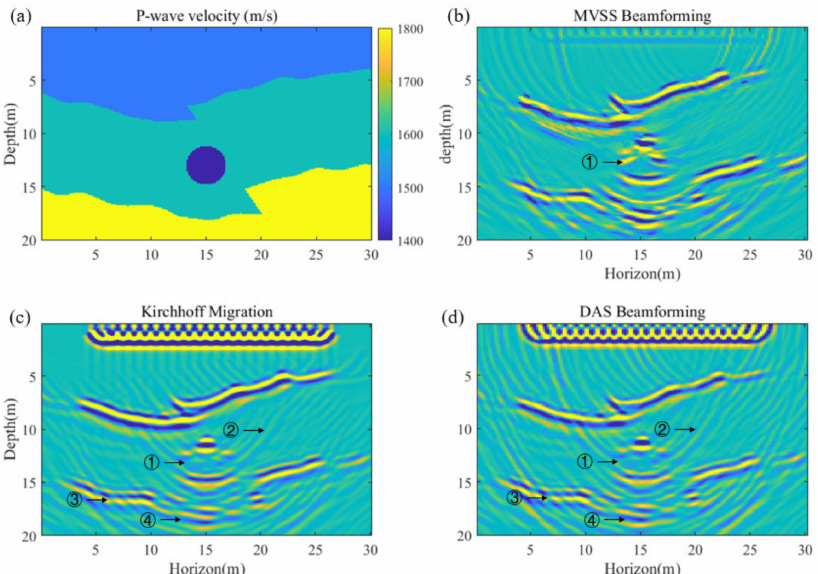
Figure 18. Model C-2. ( a ) True velocity model. ( b ) Imaging result of MVSS beamforming. ( c ) Imaging result of Kirchhoff migration. ( d ) Imaging result of DAS beamforming.